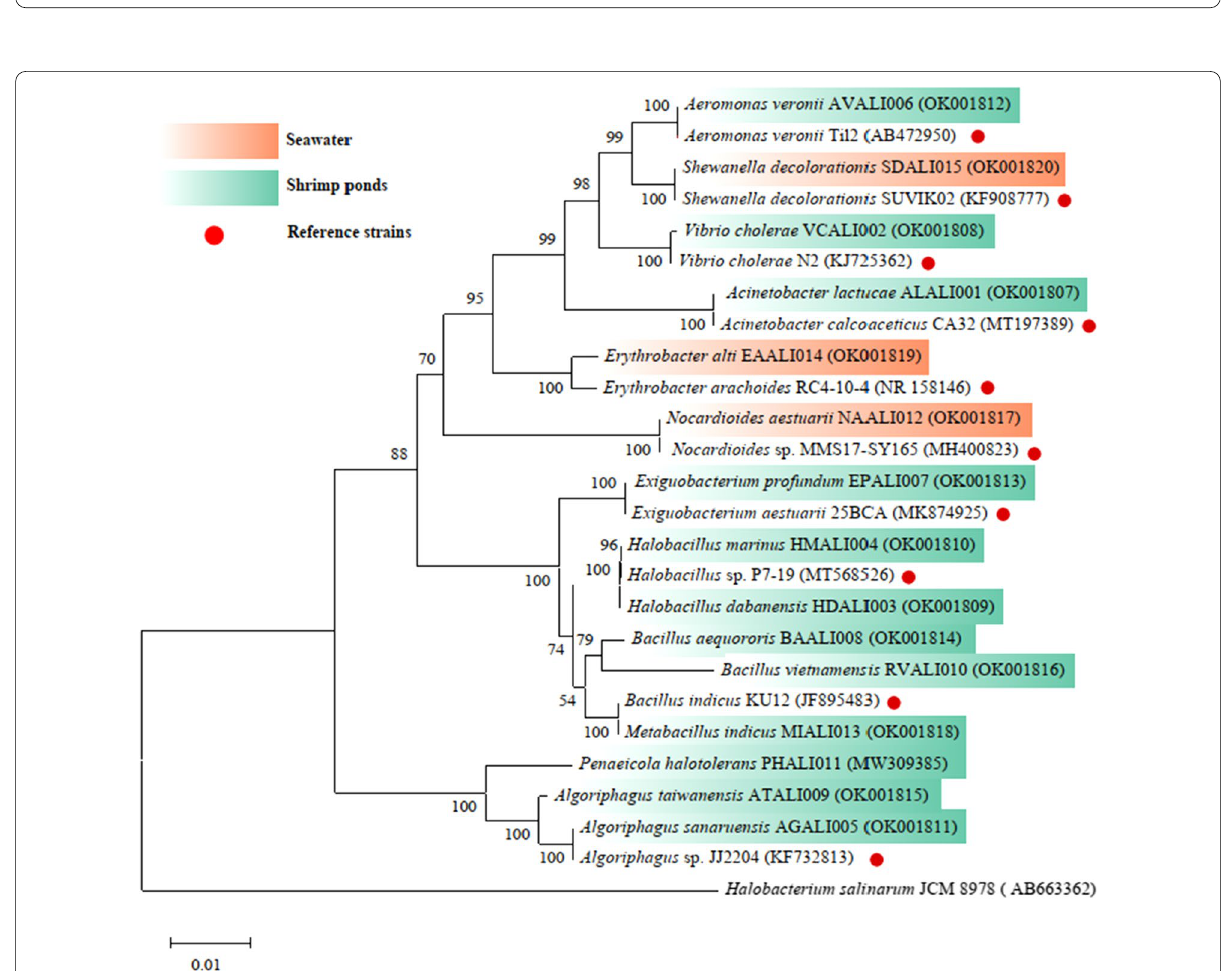
Fig. 3 Neighbor-joining phylogenetic tree based on 16S rRNA gene sequences showing the phylogenetic position of all isolated strains. Halobacterium salinarum JCM 8978 (AB663362) was used as the outgroup. Bootstrap support is shown for cases where the value was greater than 50% based on 1000 replications. The scale bar indicates 0.01 substitution per nucleotide position. Strains from the shrimp ponds were highlighted as green shade, and the strains from surrounding seawater were highlighted as orange shade, while the reference strains were marked with red dots, and GeneBank accession numbers listed after each sequence